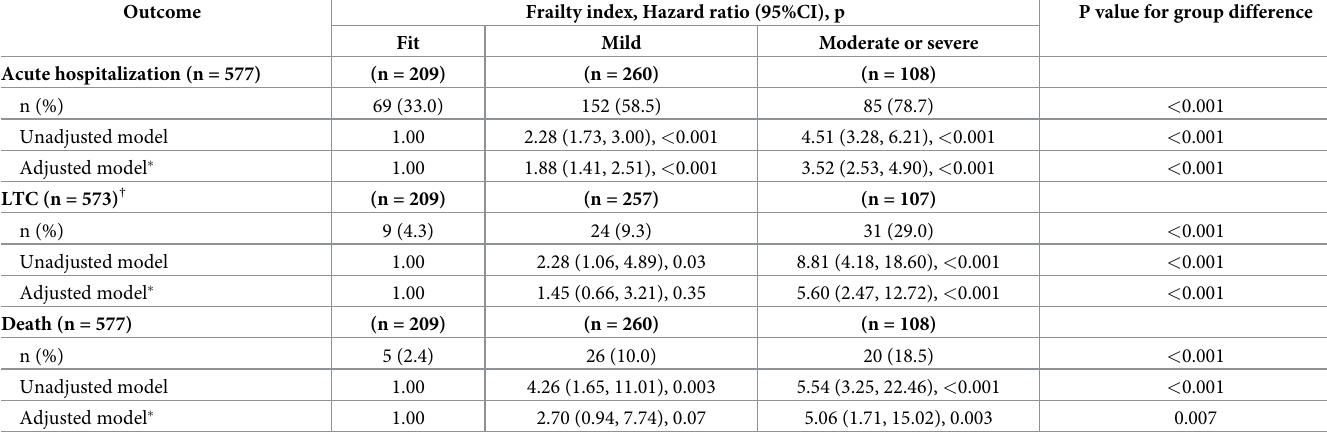
Table 2. Proportion of residents having a healthcare outcome during follow-up and hazard ratios by frailty categories.